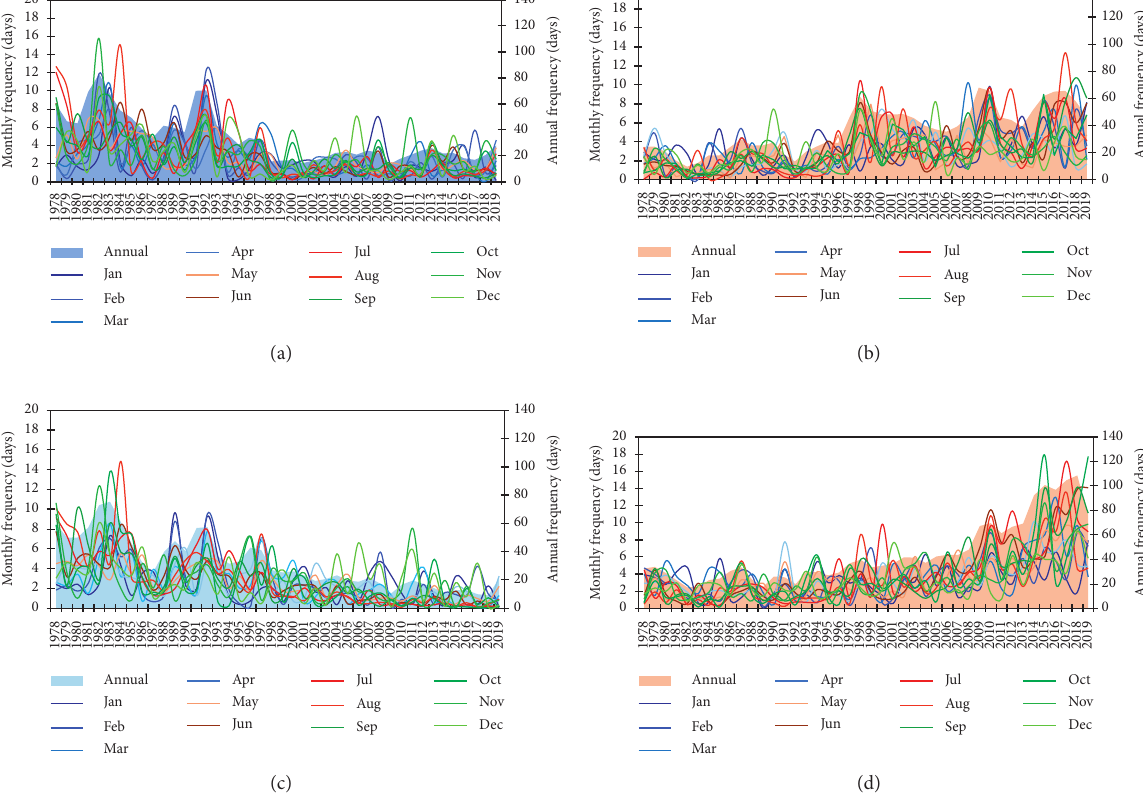
Figure 11: Country-averaged monthly and annual frequencies for the period 1978–2019 where (a) TX10p (cold days), (b) TX90p (warm days), (c) TN10p (cold nights), and (d) TN90p (warm